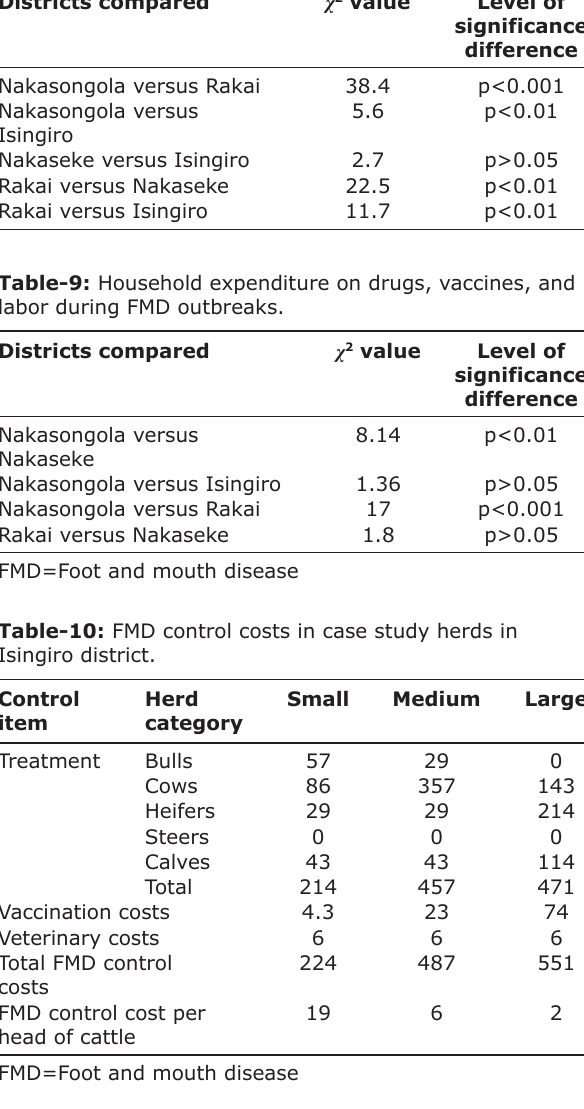
Table-8: Loss of income due to milk loss and live cattle sales. Districts compared